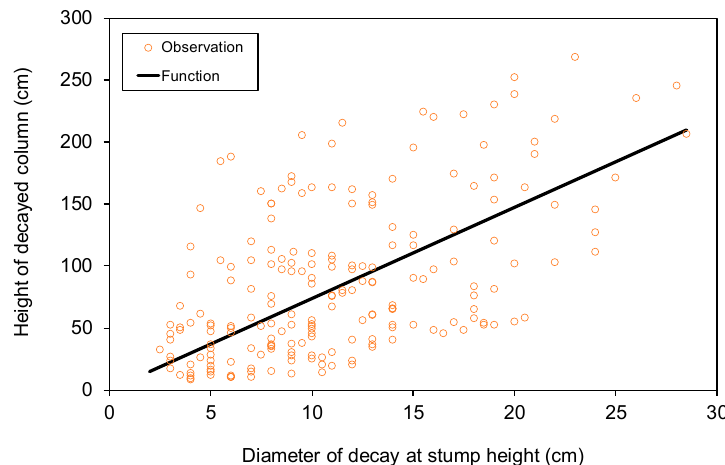
Figure 7. Measured observations ( n = 202) of the diameter and height of the decayed column in the stem, and the calculated line of the height of the decayed column (Table 8) as a function of the diameter of the decayed column at the stump height. Table 8. Regression model for the height of the decayed column in the stem. Coe ffi cient Estimate of Coe ffi cient Standard Error of Estimate t -Value B 7.362